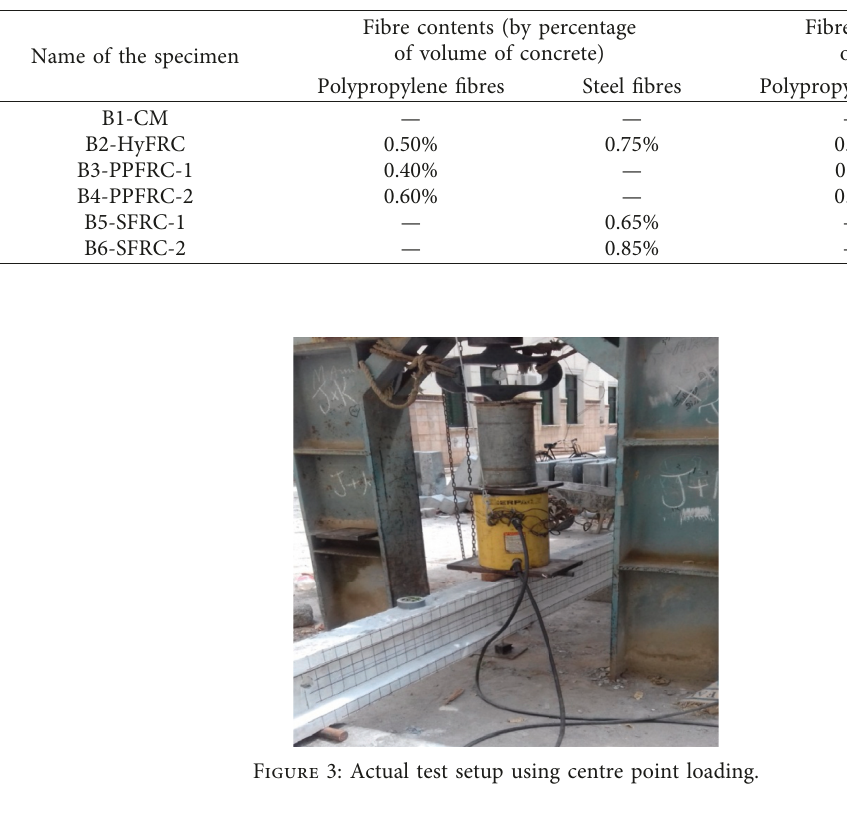
Figure 2: Detail of shear reinforcement in full length of an I-shaped girder. Table 3: Fibre contents in all six concrete mixes.